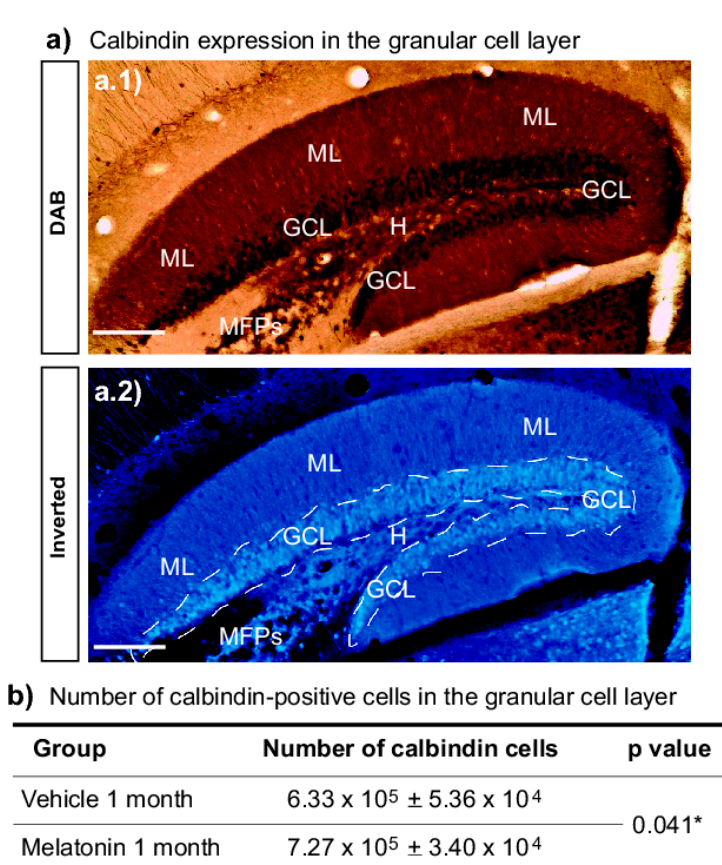
Figure 2. Experimental design. Melatonin was administered for one- or six-months. At the end of the treatment, the final ages of the mice were 3 or 8 months, respectively. Melatonin was prepared in a concentration to yield a dose of 8 mg/kg of body weight (b.w.) per day during the treatment. Five male Balb/C mice were included per group.